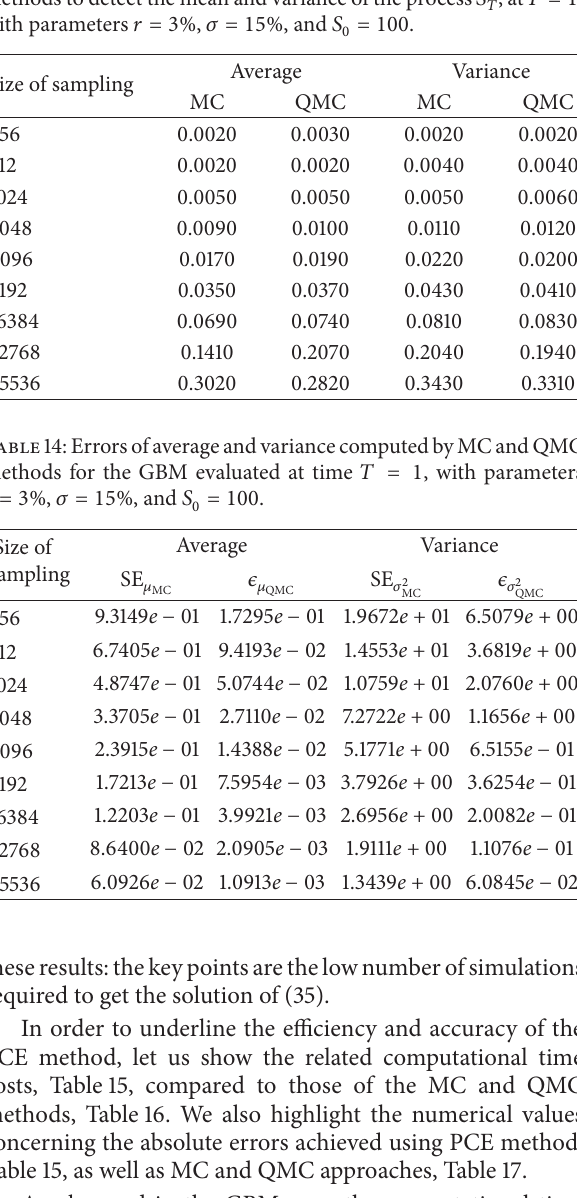
Table 15: Time computational costs and absolute error of mean and variance of PCE, concerning Vasicek model 𝑅 𝑇 at time 𝑇 = 1 . The